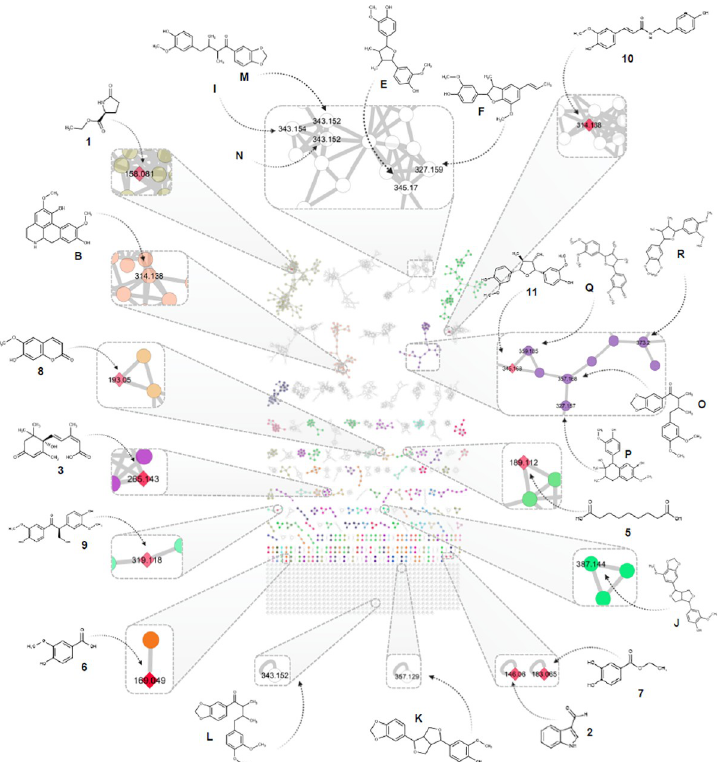
Fig 3. Molecular network in positive ionization mode, generated from the UHPLC-HRMS/MS analysis of the CH 2 Cl 2 fractions obtained from EtOH extracts of Nectandra oppositifolia leaves and twigs with a cosine similarity score cut-off of 0.6. Chemical structures are shown in their respective nodes and clusters. Isolated compounds are represented by a red rhomboid (1–12). The putatively identified compounds (A-S) are also shown in the topology. Numbers inside the nodes correspond to the precursor mass for each feature. The edge’s thickness is proportional to the similarity cosine between nodes. Several colors represent the different chemical consensus classes according to ClassyFire.